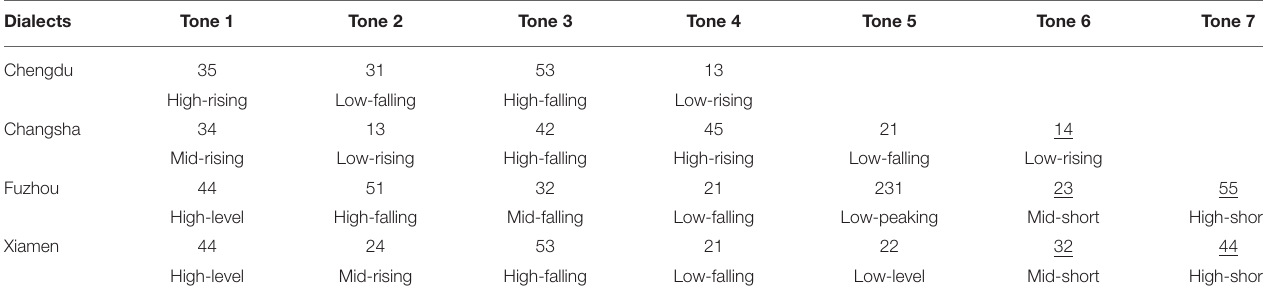
TABLE 1 | The five-scale tone letters and tone features of lexical tone inventories among four Chinese dialects.